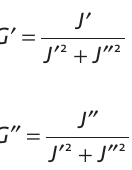
Figure 5: Unified plots of the variation of the storage modules G’ with frequency for three bentonite suspensions (6, 8 and 10wt%). Low frequency values are derived by trans- forming creep data (open symbols), and high frequency values are measured by oscillatory measurements with a Carri-Med rheometer (solid